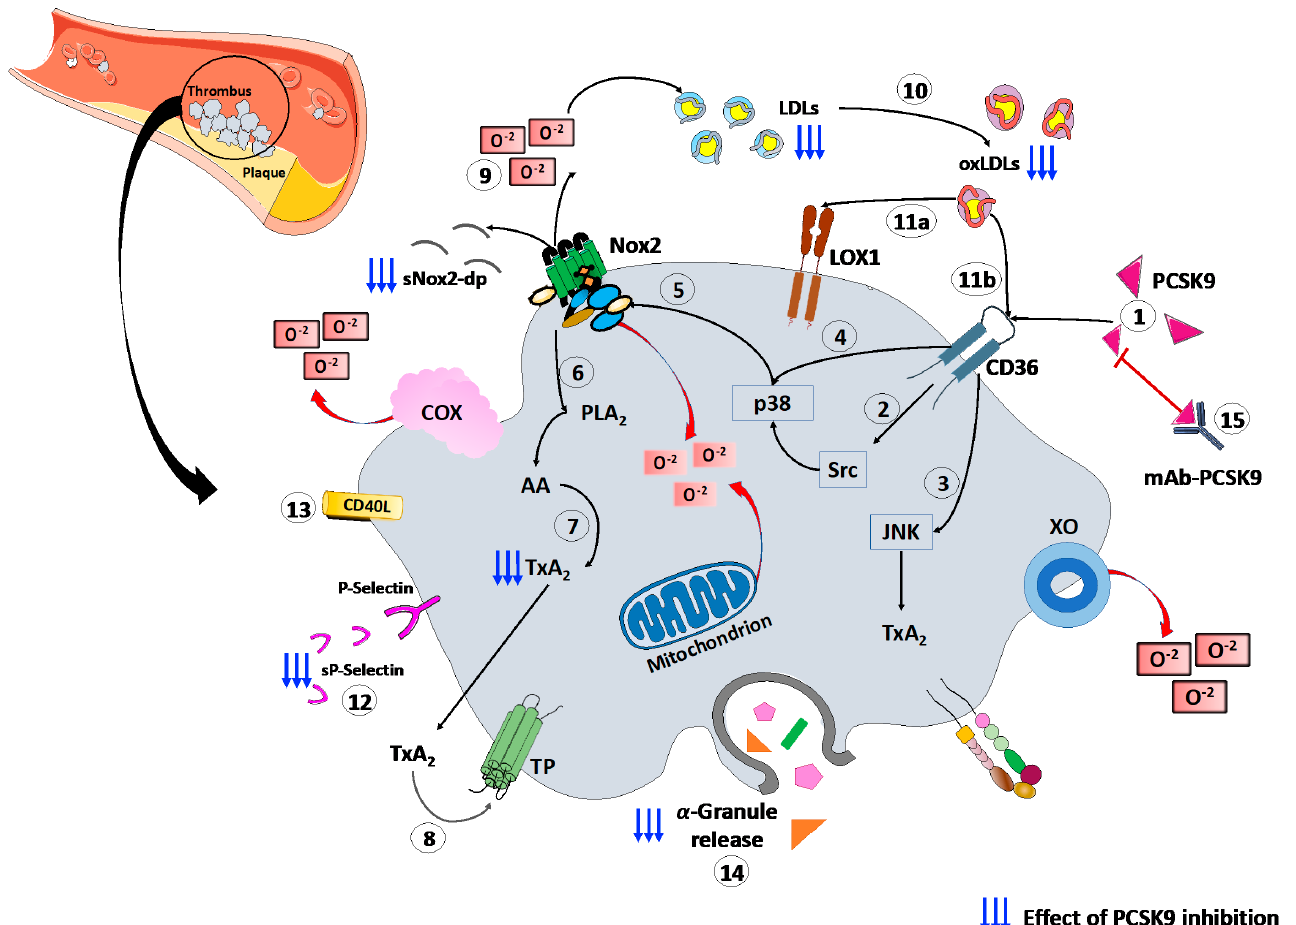
Figure 1. PCSK9 effects on platelet activation. (1) PCSK9 directly binds CD36 receptor on platelet’s surface, enhancing platelet activation and the downstream signaling, including (2) Src and (3) JNK kinase. Moreover, PCSK9 increases the generation of ROS by (4) p38MAPK phosphorylation inducing (5) Nox2 activation, (6) PLA2, (7) AA and (8) TxA2 signaling. (9) The Nox2-mediated ROS production increases (10) ox-LDLs formation that amplify the platelet activation through both (11a) LOX1 and (11b) CD36 platelet receptors. All these events act as the amplifying signal for platelet